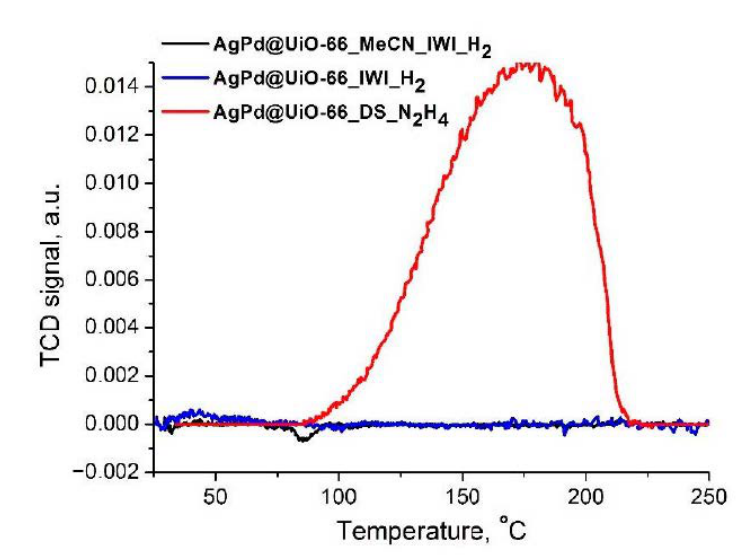
Figure 6. H 2 -TPR profiles of 1% AgPd@UiO-66 prepared by using DS_N 2 H 4 (red), IWI_H 2 (blue), and MeCN_IWI_H 2